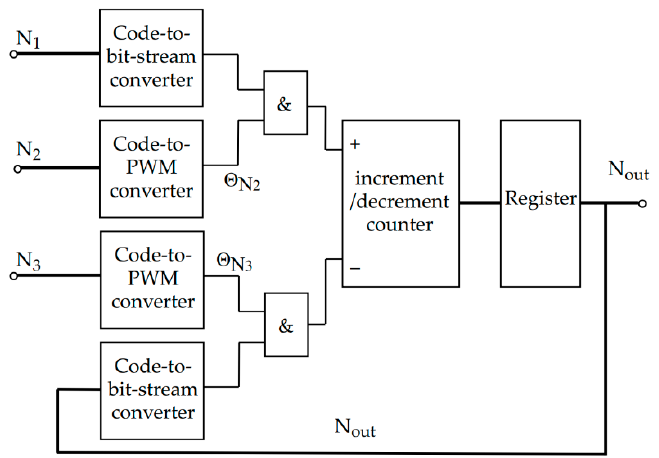
Figure 5. Result of pulse-frequency sweeping algorithm simulation. Figure 5. Generalized block diagram of the streaming multiplication-division